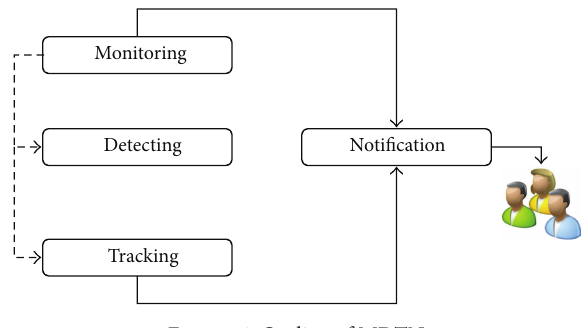
Figure 4: Outline of